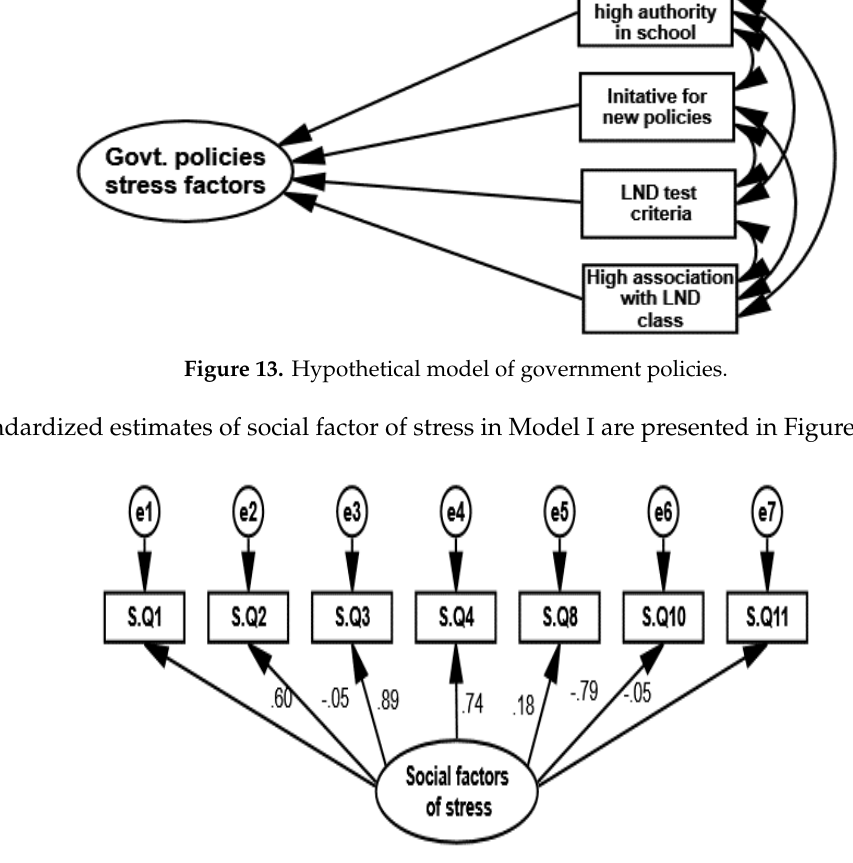
Figure 14. Standardized estimates of social factors of STRESS.